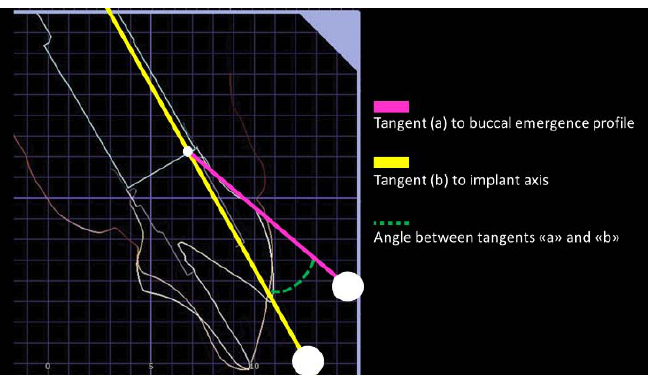
Figure 3. Emergence angle (EA) calculation procedure. After turning the analogic impression into a digital form, the customized emergence profile shape was planned and designed. The EA was calculated by drawing a line (yellow) parallel to the implant axis, and a pink line from the implant to the abutment connection point to the emergence profile. The angle of the intersection between pink and yellow lines resulted in the emergence angle (EA). If EA score was ≥ 30 degrees, the restoration was allocated to Group 1, while if it was <30 degrees the restoration was allocated to Group 2. The definitive restoration EA angle was used for the group allocation (Figure 4).